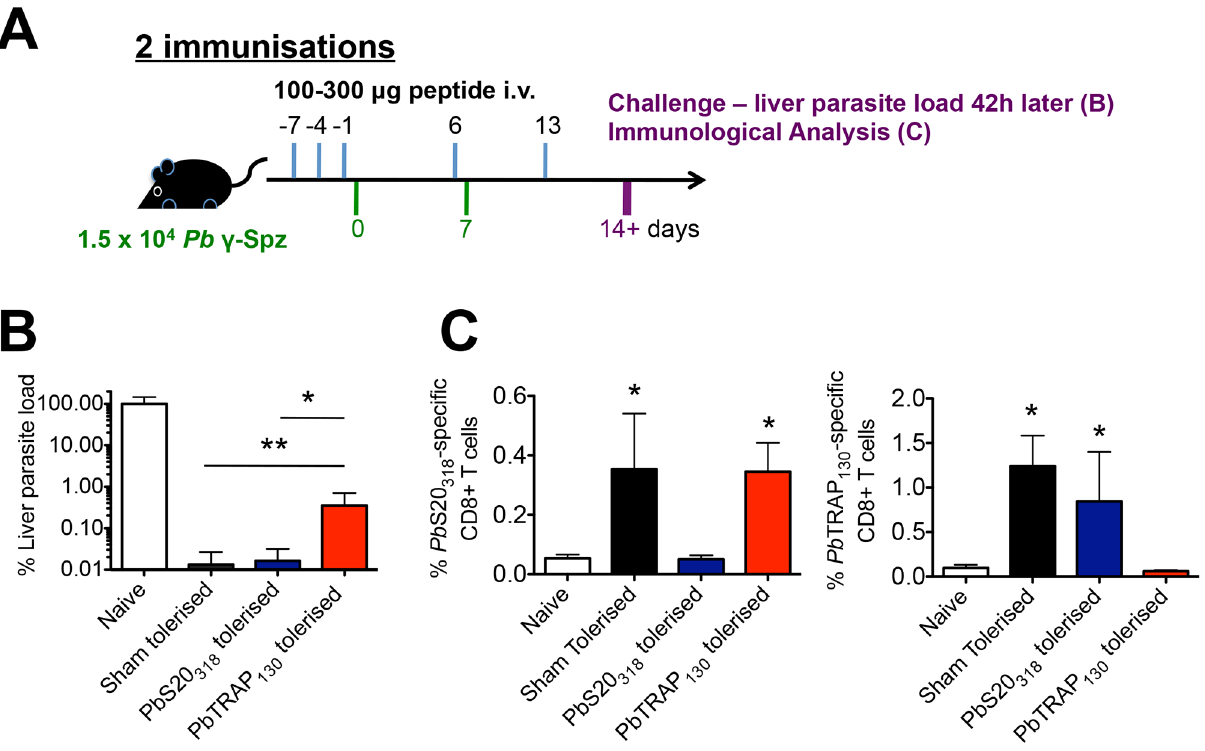
Figure 5. Pb TRAP 130 -specific CD8 + T cell responses contribute significantly to protection against malaria liver stages. ( A ) Schematic diagram of methodology. Mice were injected with Pb S20 318 or Pb TRAP 130 peptides before and after immunisation with Pb c -Spz. Two weeks after the last immunisation, mice were challenged with sporozoites and the parasite load in the liver was measured 42 hours later. ( B ) Quantification of parasite load in the livers of mice after challenge with sporozoites. Data shown are from two experiments (mean + SD), *p . 0.05 and **p . 0.01 (Kruskal-Wallis test/Post-Dunn’s test for multiple comparison). ( C ) Spleens of peptide-treated mice were assayed for the presence of Pb S20 318 or Pb TRAP 130 -specific CD8 + T cells by ICS (*p . 0.05, Kruskal-Wallis test/Post-Dunn’s test for multiple comparison).